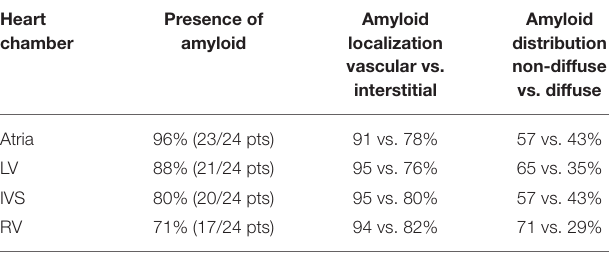
EjectionFraction;NYHA,NewYorkHeartAssociation;RV,RightVentricular.Boldidentifies significant p values ( < 0.05).